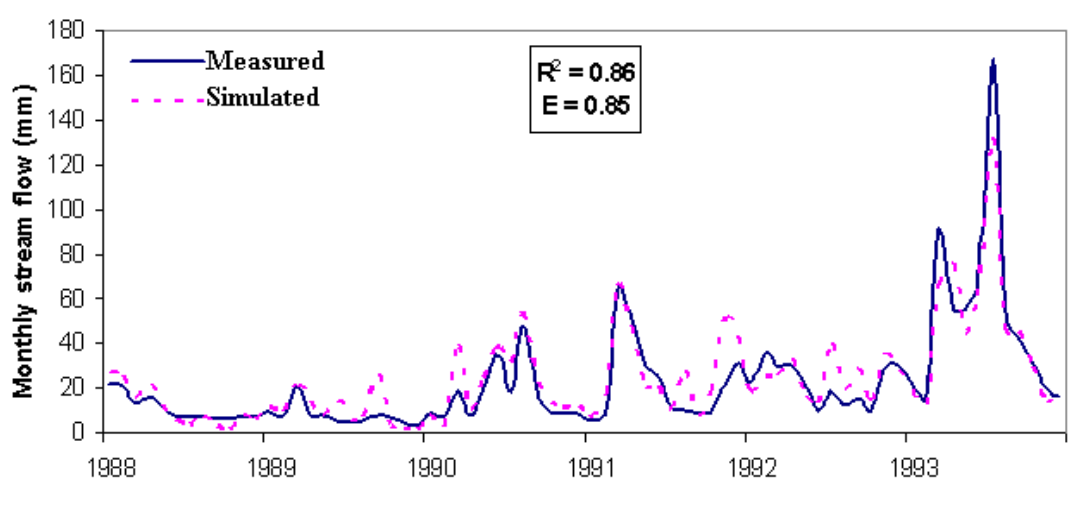
Figure 3. Monthly time series of predicted and measured streamflow at USGS gauge 05418500 (watershed outlet) for the 1988-93 calibration period.